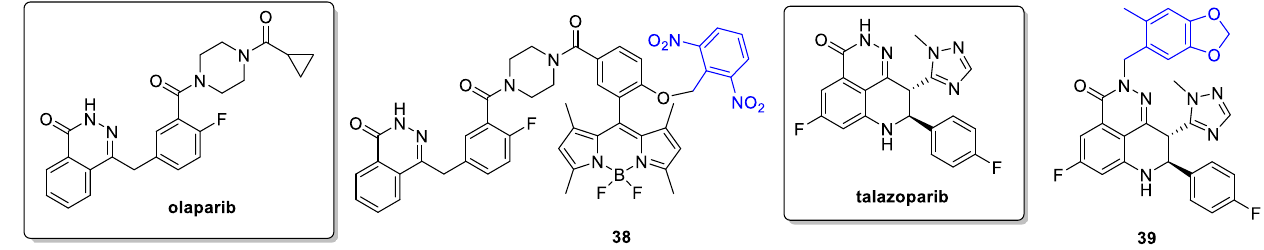
Figure 8. Photoactivatable PARP inhibitors, the PPG indicated in blue. Zhou and coworkers studied photocaging of talazoparib , an approved oral nanomolar PARP inhibitor drug [61]. The key pharmacophore for introducing the PPG unit (the lactam moiety) was determined by molecular docking so that masking disrupts hydrogen bonding interactions with the protein besides steric clashes to render the caged inhibitor inactive ( 39 ). As PPG, the o -nitrobenzyl unit was selected, allowing fast and complete release of talazoparib upon 365 nm irradiation (20 µ M in methanol, 4.1 mW/cm 2 , 5 min). Recording the dose-response curves of talazoparib and its caged counterpart on PARP-1 enzyme, a 380-fold difference was found ( talazoparib : IC 50 = 0.005 µ M, photocaged drug: IC 50 = 1.9 µ M). Further assessment of the pharmacological effects at a cellular level (inhibi- tion of poly ADP-ribosylation in HeLa cells) also showed a significant, 658-fold difference ent and caged talazoparib was studied in BRCA1- and BRCA2-defective cell lines (MX-1, Capan-1: talazoparib : IC 50 = 0.015 µ M and 0.003 µ M; photocaged drug: IC 50 = 1.9 µ M